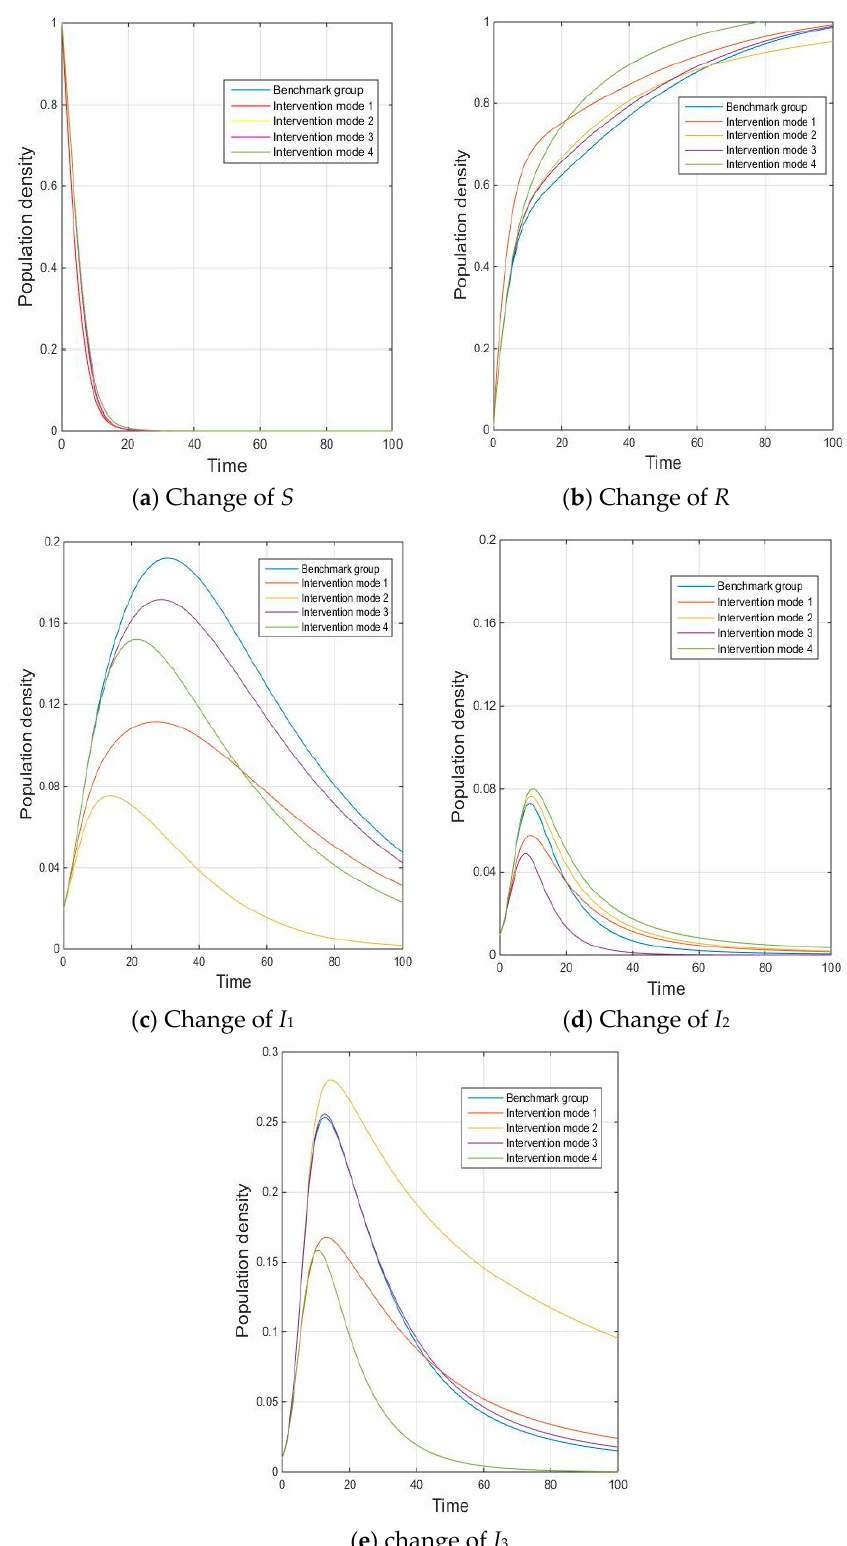
Figure 7. Impact of different intervention methods on various groups.